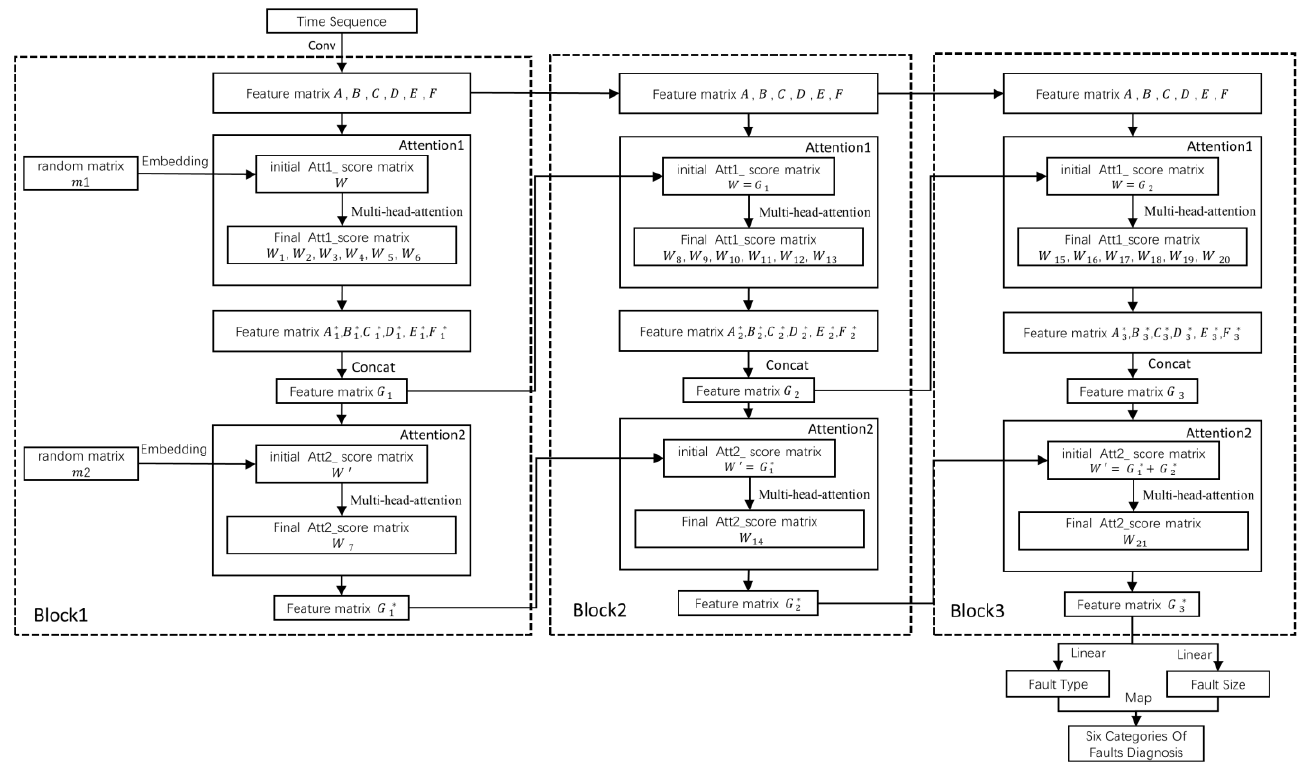
Figure 6. Multiblock Learning.